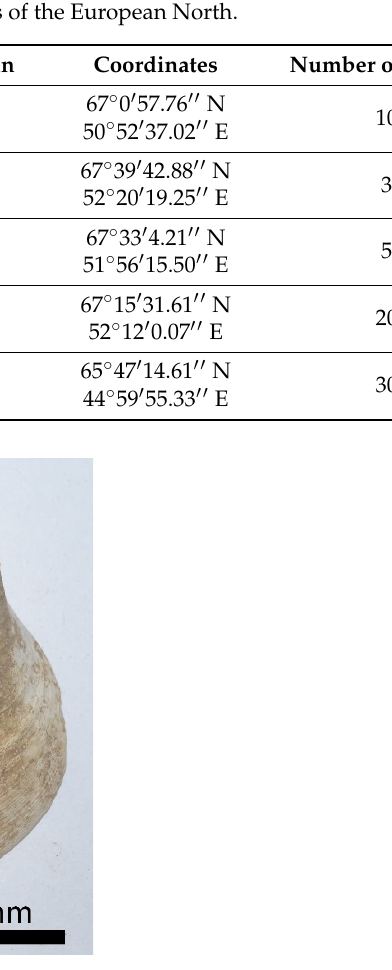
Figure 2. The subfossil shell of the marine mollusk Arctica islandica from the Sula outcrop. Table 1. Locality and River basin of fossil shells of the European